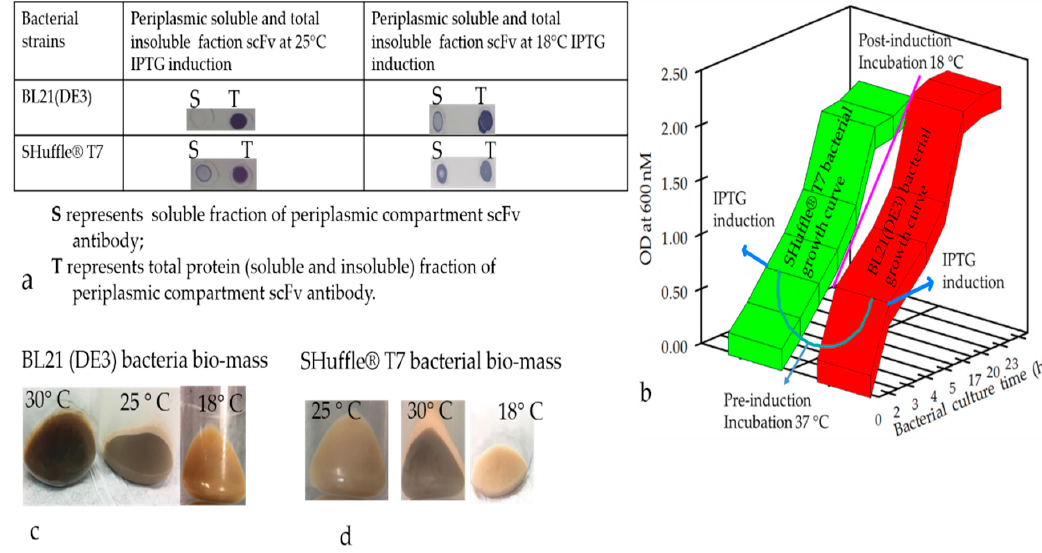
Figure 4. Expression pattern of the antibody fragments at different temperature conditions. ( a ) Dot-blot analysis of soluble and insoluble antibody proteins from induced bacterial cell pellets from 2 bacterial strains. The soluble antibody fraction and total antibody proteins were isolated and spotted onto the nitrocellulose membrane. The presence of antibodies in the spots was examined by using horseradish peroxidase (HRP) tagged anti-myc monoclonal antibody, followed by a short incubation with Tetramethylbenzidine (TMB) substrate. ( b ) Pictorial depiction showing the growth curve of two bacterial strains at two different temperatures. ( c ) Image showing the color of the bacterial cell pellets expressing antibody fragments in periplasmic and cytosolic compartments. Three batches of bacterial cultures were induced at the same density (O.D of 0.8) but at 3 different temperatures as shown in the figure and pelleted after 14 h.